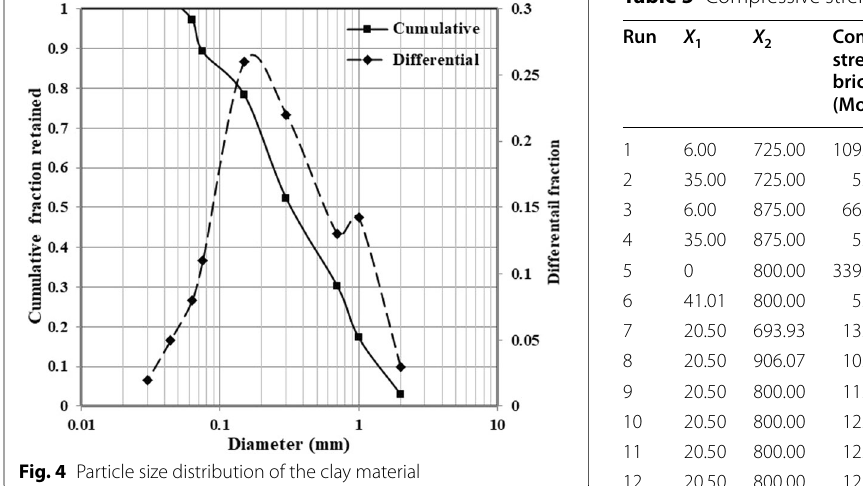
Table 5 Compressive strength of clay‑PA and clay‑PB fired